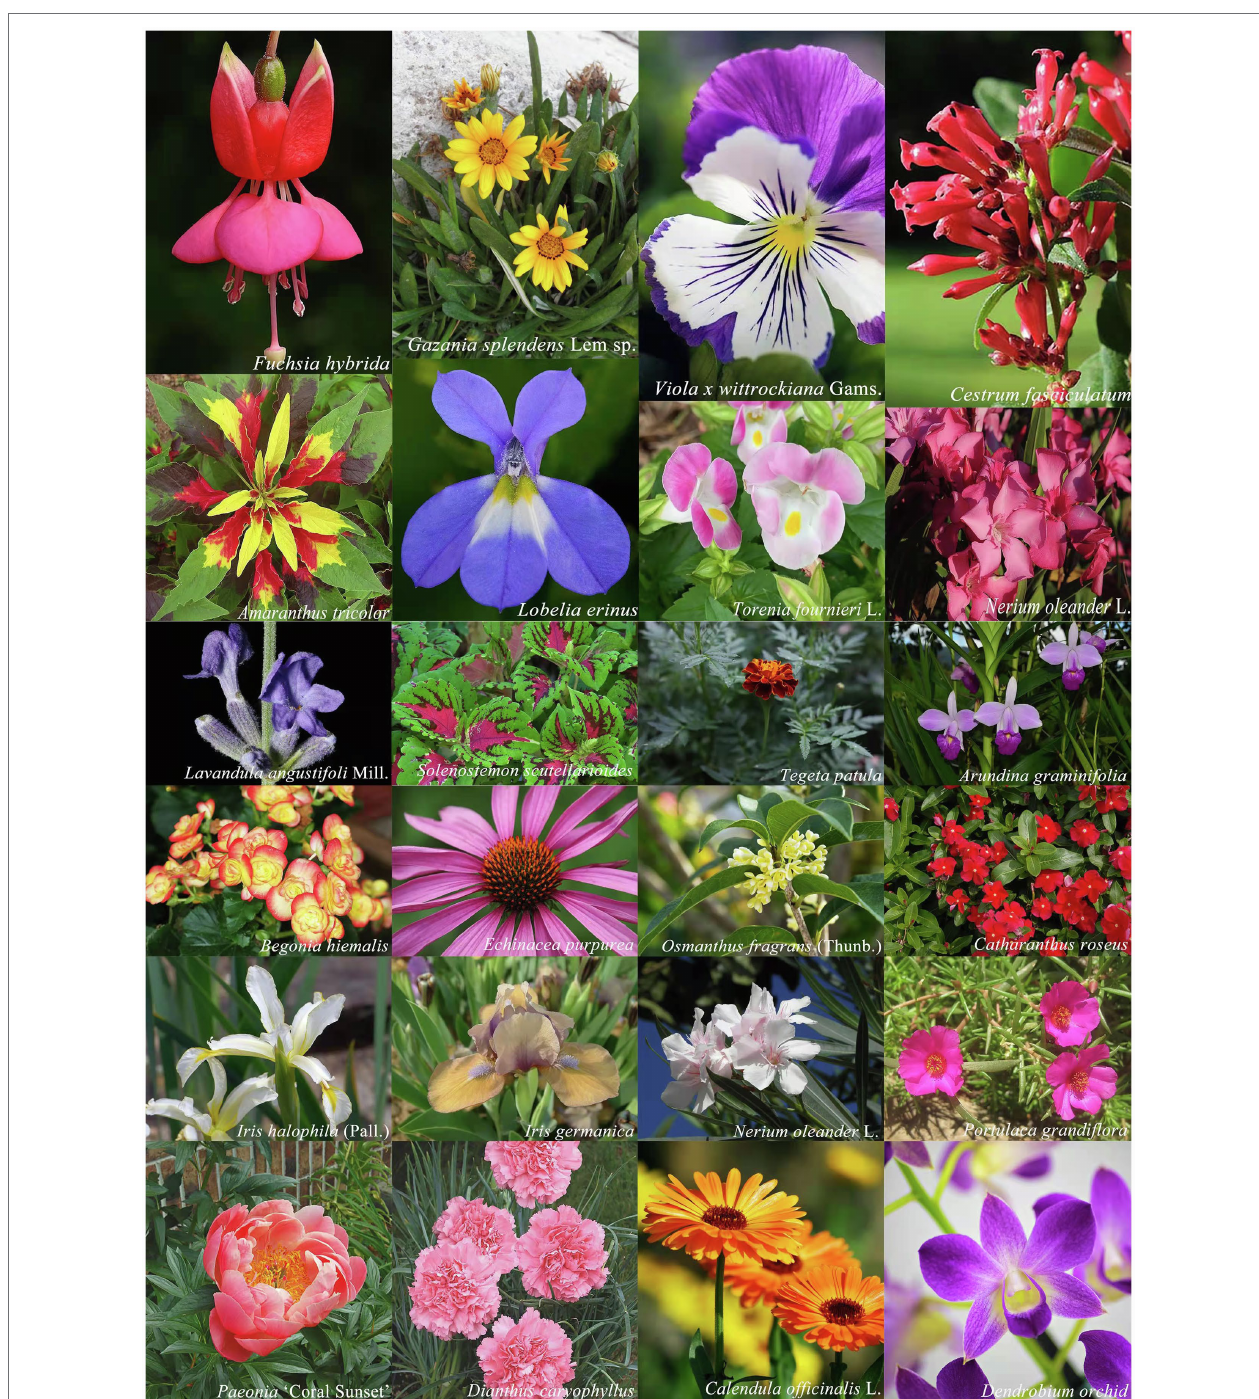
FIGURE 3 | Photos exhibition of some ornamental plants with beautiful